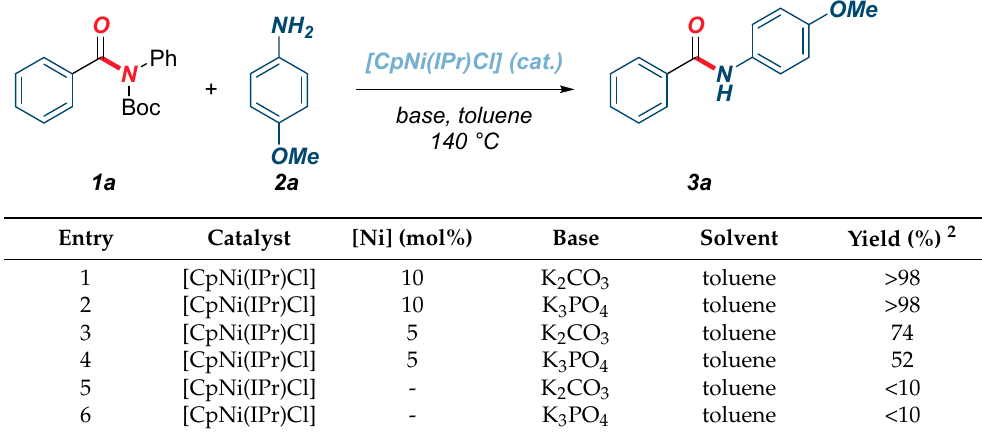
Table 1. Optimization of the transamidation of amide 1a using [CpNi(IPr)Cl]. 1